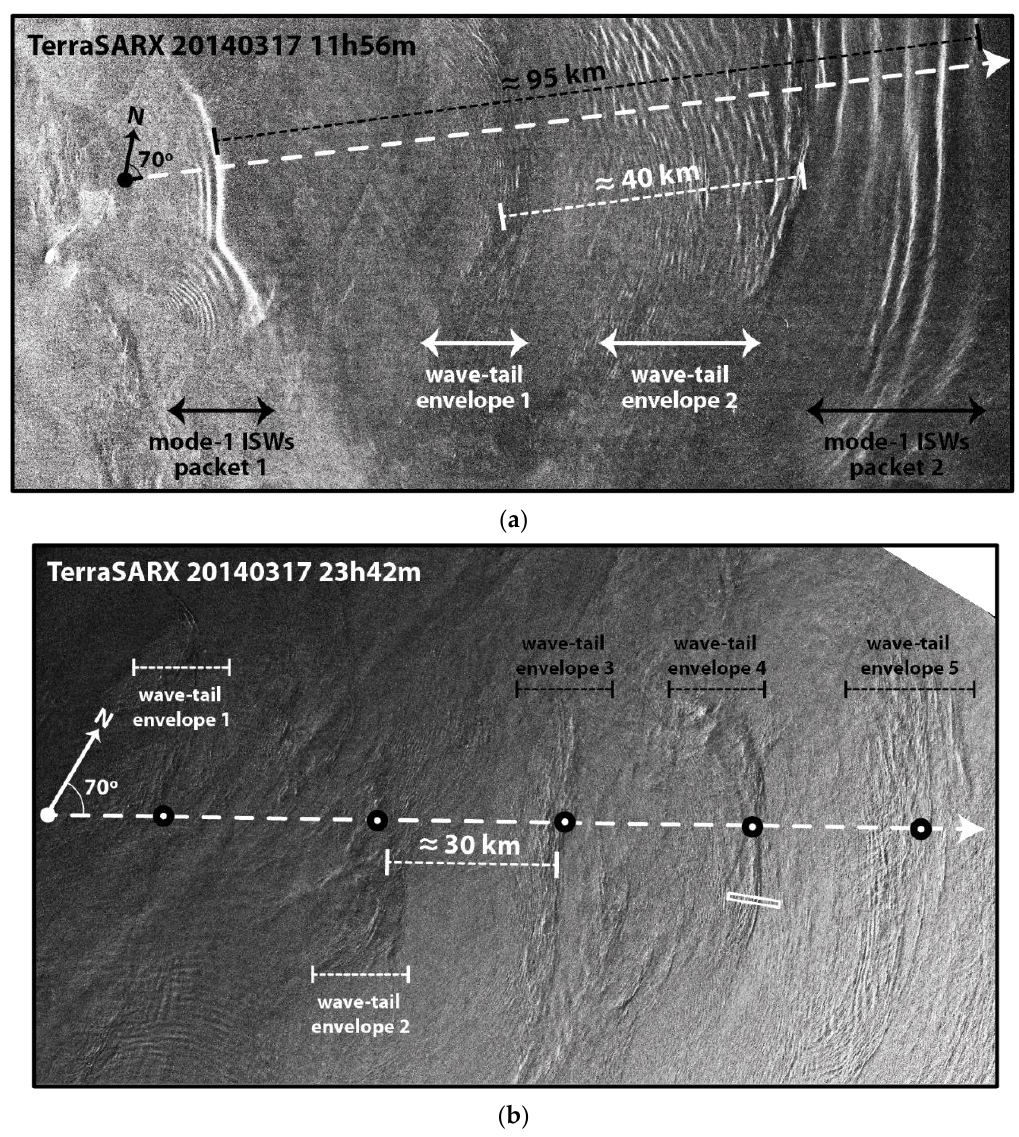
Figure 3. ( a ) Subset of a TerraSAR-X image, approximately 123 × 58 km 2 , showing a typical view of the ISW field along 9°N in the Andaman Sea (see Figure 1 and Supplemental Material S1 for location). ISWs are propagating approximately towards 70°TN (white dashed arrow), and two mode-1 packets may be identified with a separating distance of roughly 100 km. In between these, two “wave-tail” envelopes are also depicted by white arrows and are spaced by about half of the previous wavelength; ( b ) Subset of a TerraSAR-X image, approximately 167 × 94 km 2 , showing a typical view of the ISW field along 10°N in the Andaman Sea (see Figure 1 for location). The wave field is propagating approximately towards 70°TN (white dashed arrow), but no mode-1 packets are observed. Instead, five regularly-spaced “wave-tail” envelopes are depicted by dashed borderlines. The white rectangle depicts the location of an ISW transect shown in Figure 4, and is consistent with a mode-2 ISW-like wave.